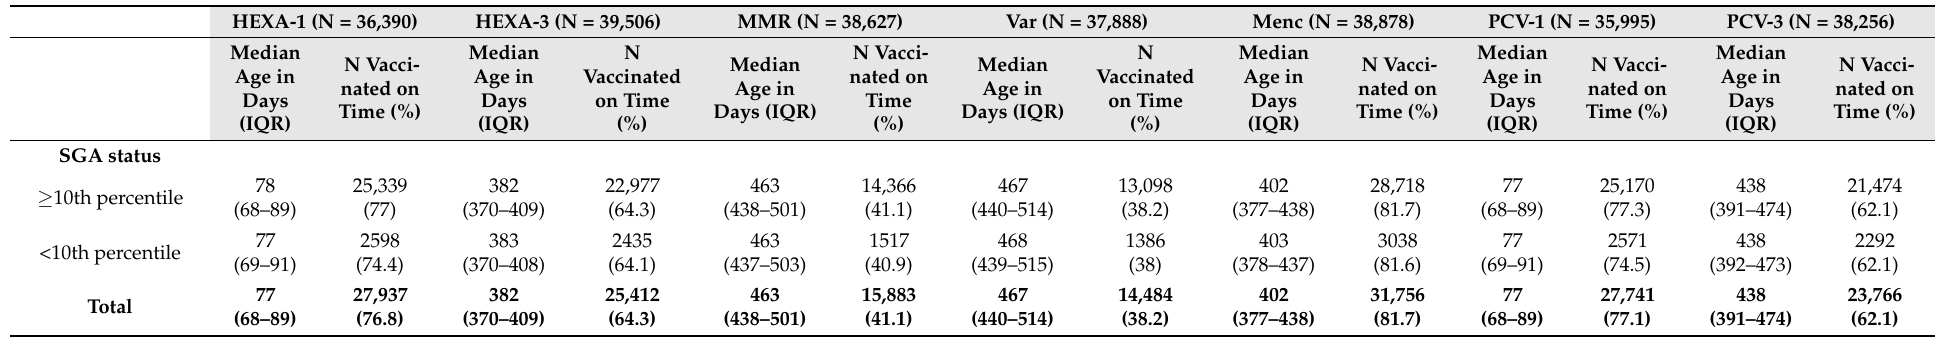
Table 3. Data on age at vaccination (median age and interquartile range—IQR) and timeliness of vaccination for SGA status at birth (<10th percentile; ≥ 10th percentile) for HEXA-1, HEXA-3, MMR, Var, MenC, PCV-1, and PCV-3 vaccine